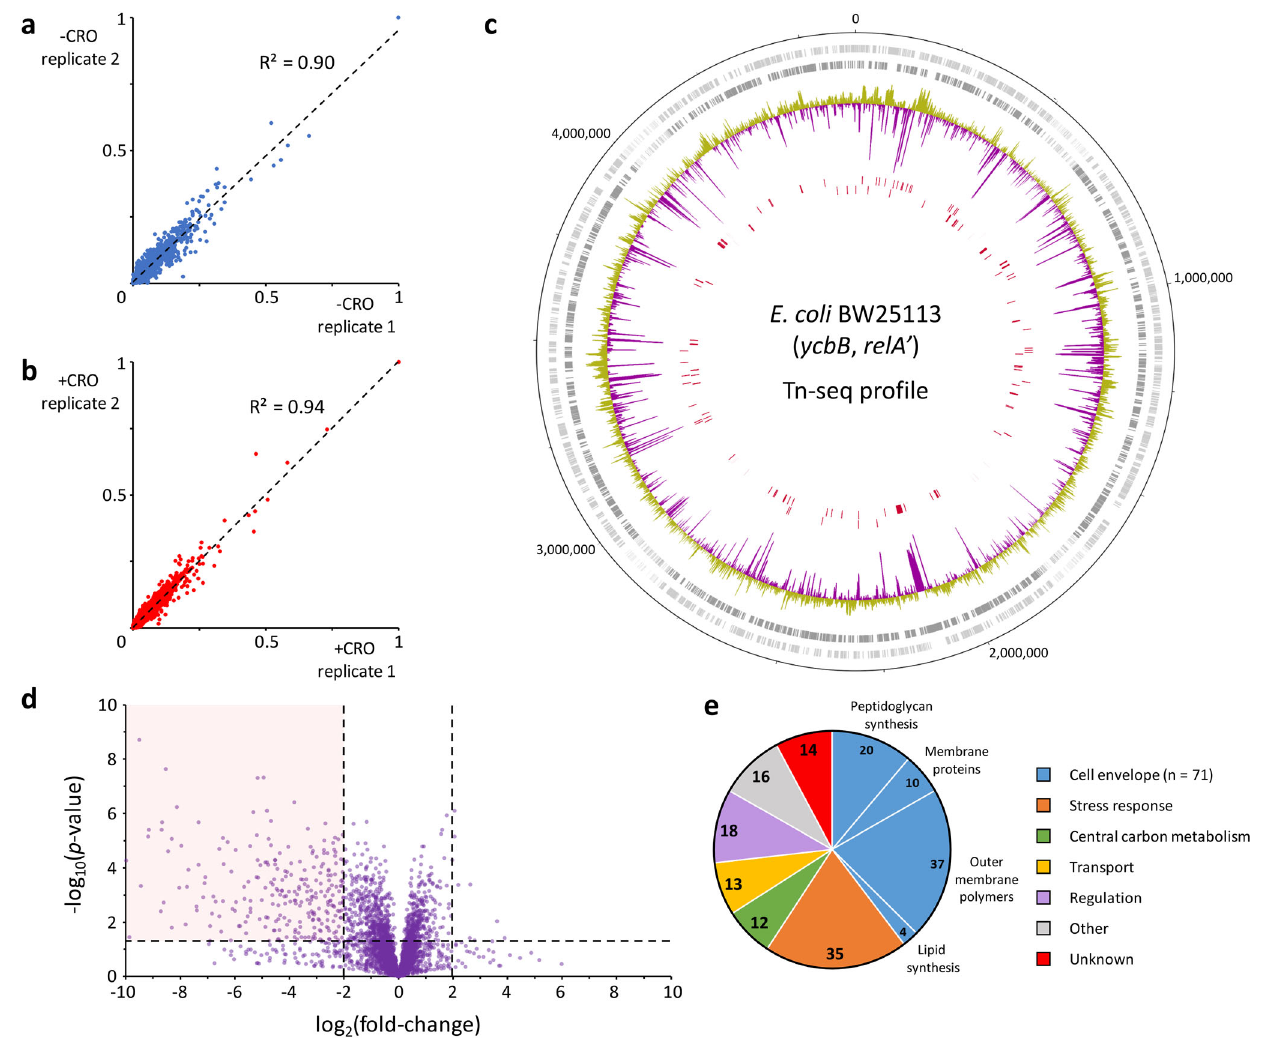
Fig. 2 | Genome-wide transposon sequencing in E. coli BW25113( ycbB , relA ’ ) grown in the absence ( − CRO) or presence (+CRO) of ceftriaxone. a , b Correlationofnormalizedaverage read numbersperCDSfortwosequenced technical replicates obtained for the − CRO and +CRO conditions, respectively. c Frequency and location of transposon insertions. Rings, outermost to inner- most, correspond to: (i) the BW25113 coordinates; (ii) the sense (light gray) and antisense (gray) CDSs; (iii) the log 2 of the fold-change of insertion for the − CRO versus+CROconditions.Datafor − CROto+CROratiossmallerandgreaterthan1 appear in yellow and purple, respectively; and (iv) the sense and antisense CDSs